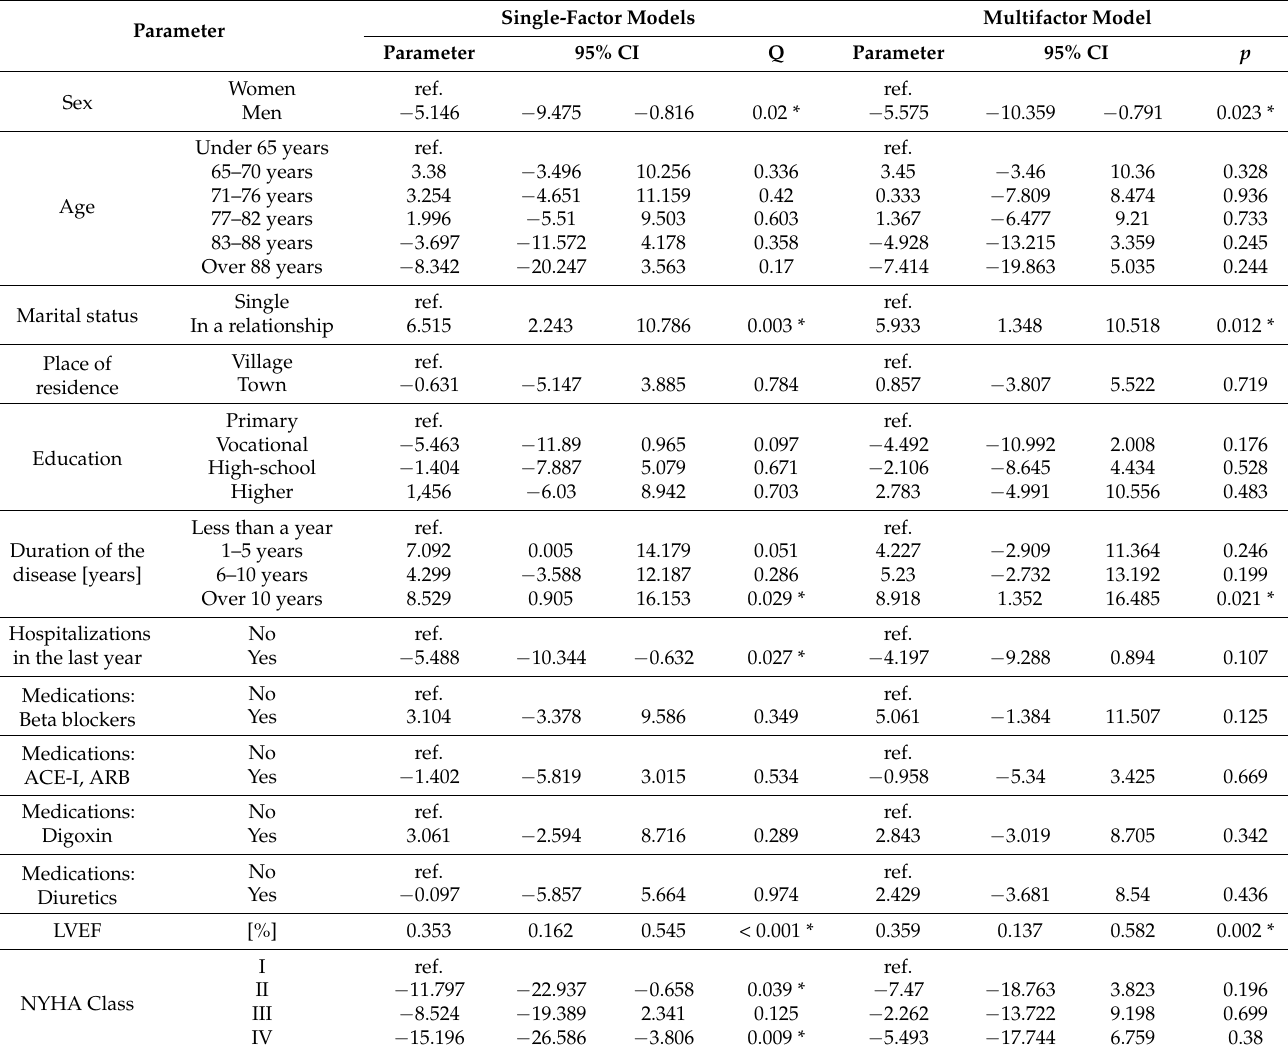
Table 3. Results of the single-factor analysis and multifactor analysis of EHFScB-9 self-care questionnaire determinants in the study group (n =